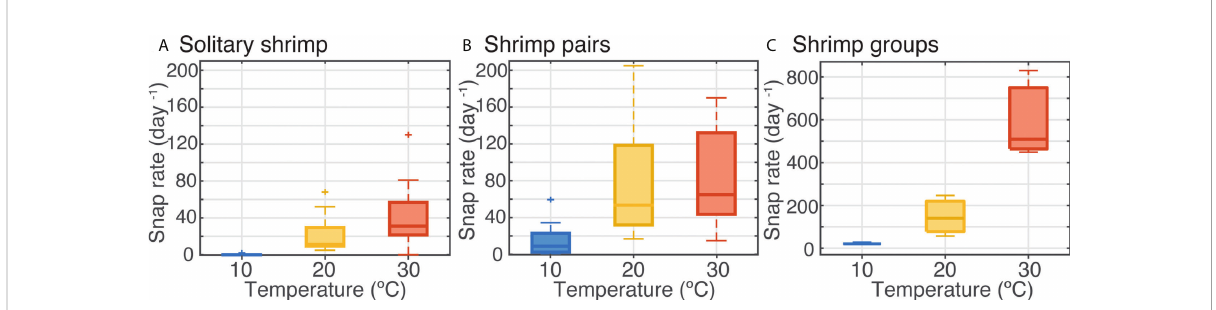
FIGURE 4 Effect of temperature on sound production by snapping shrimp in different social environments: (A) solitary, (B) pairs, and (C) groups of ten. Box plots show median values (solid horizontal lines), 50 th percentile values (box outline), and 90 th percentile values (whiskers) of snap rate (per